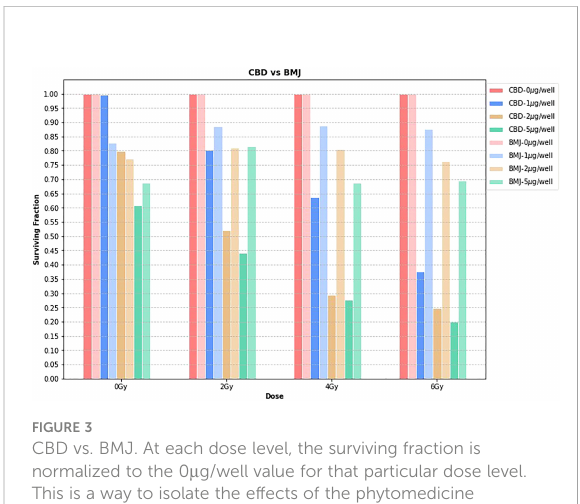
FIGURE 3 CBD vs. BMJ. At each dose level, the surviving fraction is normalized to the 0 m g/well value for that particular dose level. This is a way to isolate the effects of the phytomedicine treatment from the effect of the ionizing